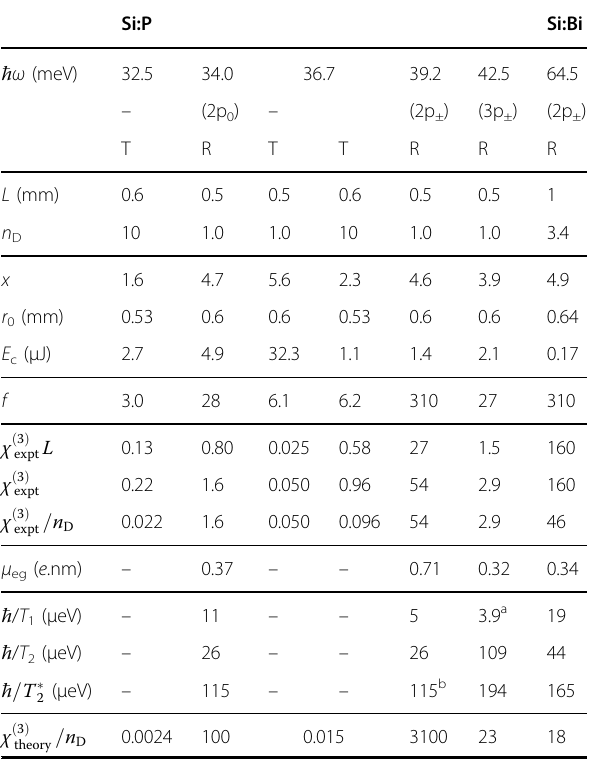
Table 1 Third-order susceptibility for Si:P and Si:Bi both on and off-resonance